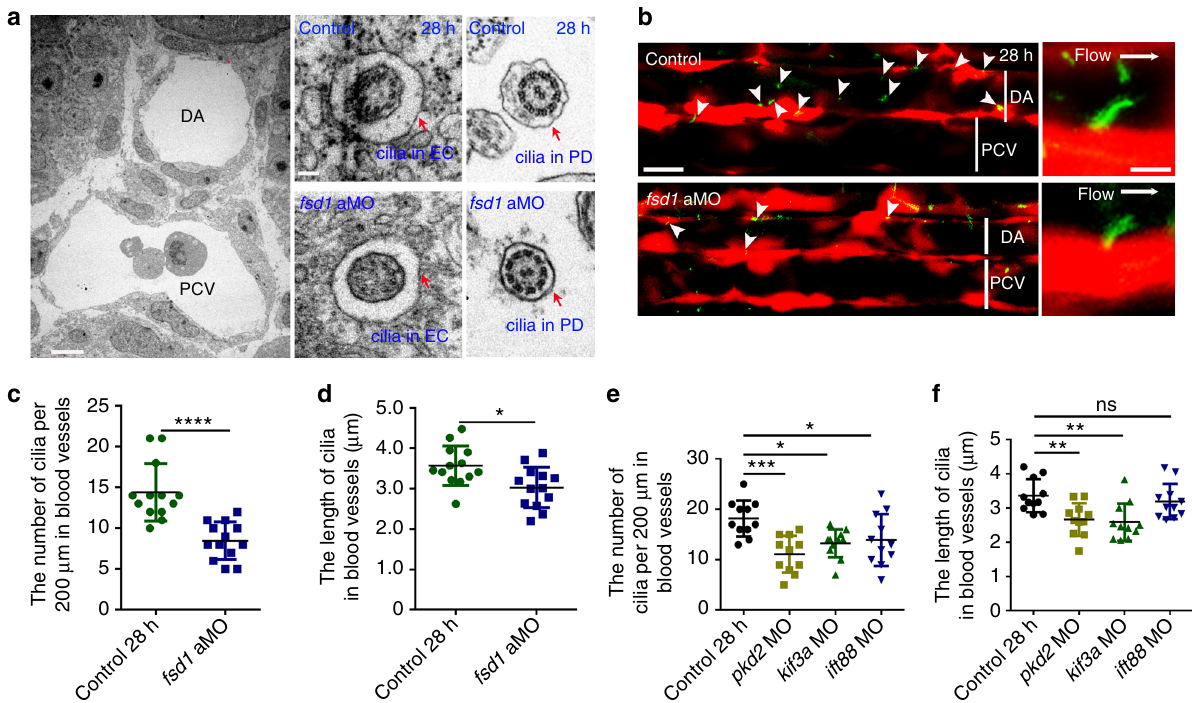
Fig. 2 Loss of cilia genes causes primary cilia defects in blood vessels in the aorta-gonad-mesonephros (AGM) region. a Transmission electron microscopy (TEM) imaging of blood vessels (left panel) in the AGM region in control and fsd1 -de fi cient embryos at 28 hpf. The red arrows indicate the ultrastructure of primary cilia in vascular endothelial cells (ECs) (middle panels) and motile cilia in pronephric duct (right panels). Red arrows denote cilia. Scale bars, 5 µ m (left panel) and 0.1 µ m (right panel). b Visualization of cilia in ECs in the AGM region using kdrl :mCherry/ β act:Arl13b – GFP double-transgenic line in control and fsd1 morphants at 28 hpf. The white arrowheads indicate the primary cilia in blood vessels. White bars denote DA or PCV region. Scale bars, 20 µ m (left panel) and 5 µ m (right panel). c – f The quanti fi cation of the primary cilia number and length with kdrl :mCherry/ β act:Arl13b – GFP double-transgenic line in control and cilia-impaired embryos at 28 hpf. Data in c , d were analyzed by Student ’ s t -test ( n = 13 embryos). Data in e , f represent the analysis results of one-way ANOVA – Dunnett test ( n = 11 embryos). Error bars, mean ± s.d. ns non-signi fi cant, * P < 0.05, ** P < 0.01, *** P < 0.001, **** P <